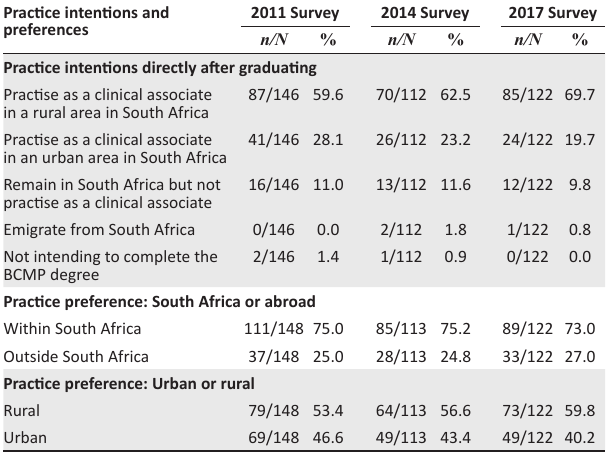
TABLE 4: Sector and level of care practice preferences of Bachelor of Clinical Medical Practice students. Most preferred